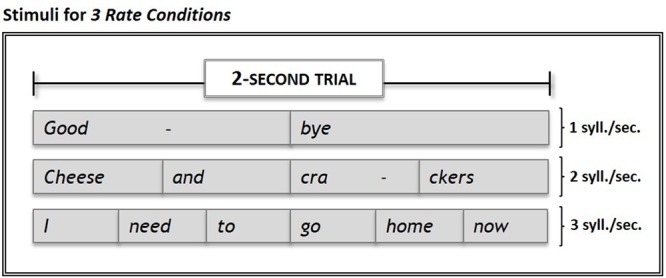
Examples of stimuli used in the experiment. Stimuli set consisted of 15 commonly-used words and phrases presented in 2-sec. trials at rates of 1, 2, and 3 syll./sec. Subjects’ overt repetitions of stimuli in each of the three Rate Conditions were compared to their response during Silence (control condition) trials. Within each run, the three rate conditions and the silence (control) condition were each sampled five times.